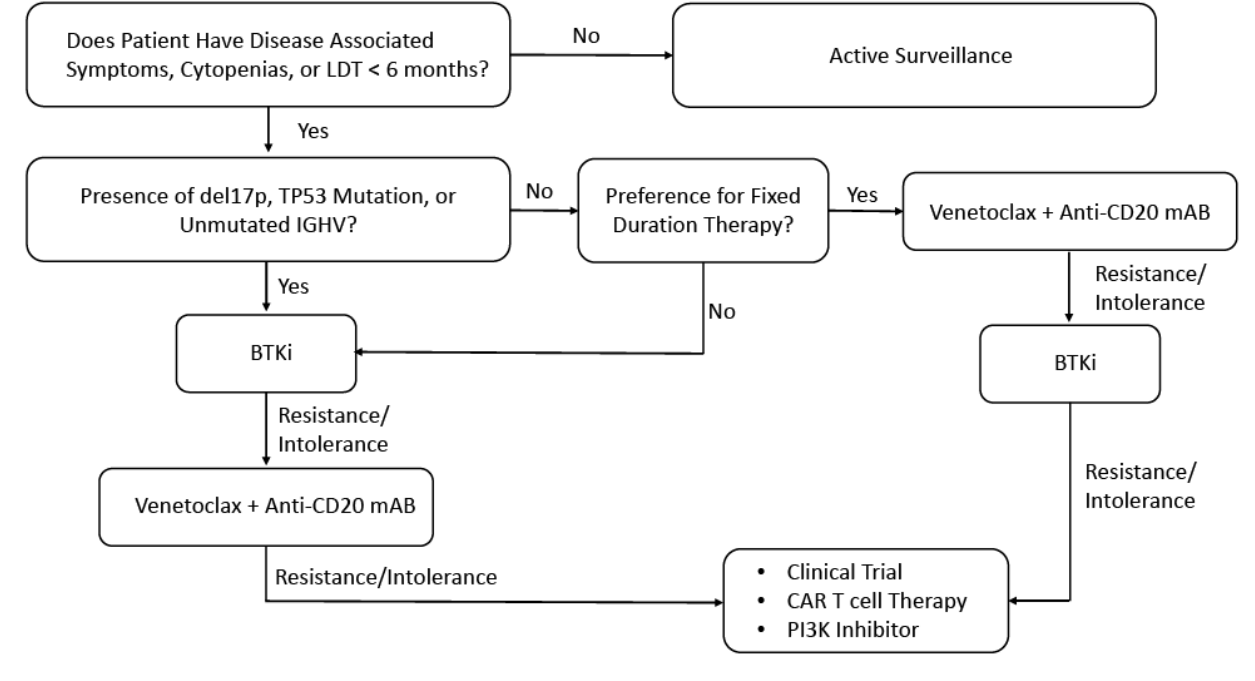
Figure 3. Proposed Management Algorithm for Patients with CLL. Abbreviations: Chronic Lym- phocytic Leukemia (CLL); Lymphocyte doubling time (LDT); Immunoglobulin heavy-chain variable region gene (IGHV); Bruton’s tyrosine kinase inhibitor (BTKi); Monoclonal antibody (mAB); Phosphoinositide 3-kinases (PI3K).